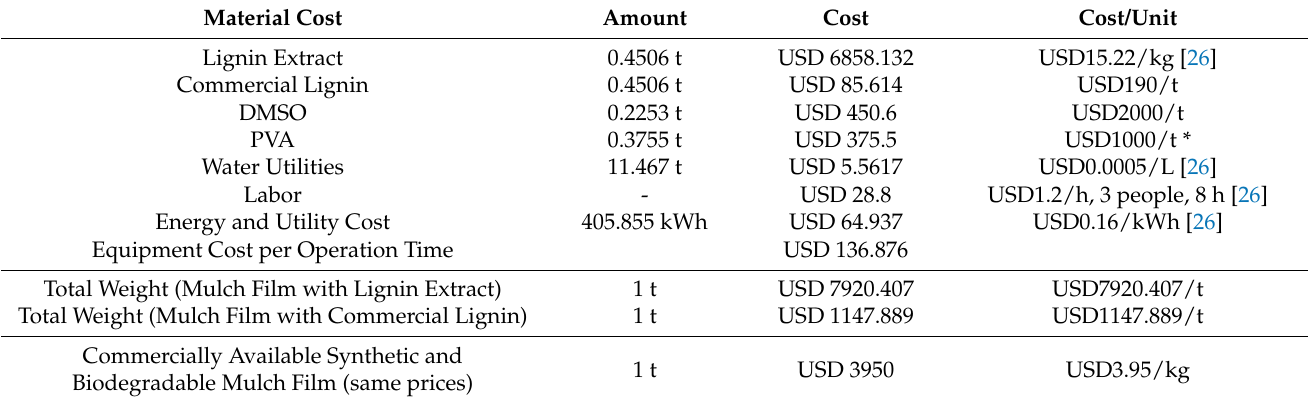
Table 6. Cost estimation of mulch film.